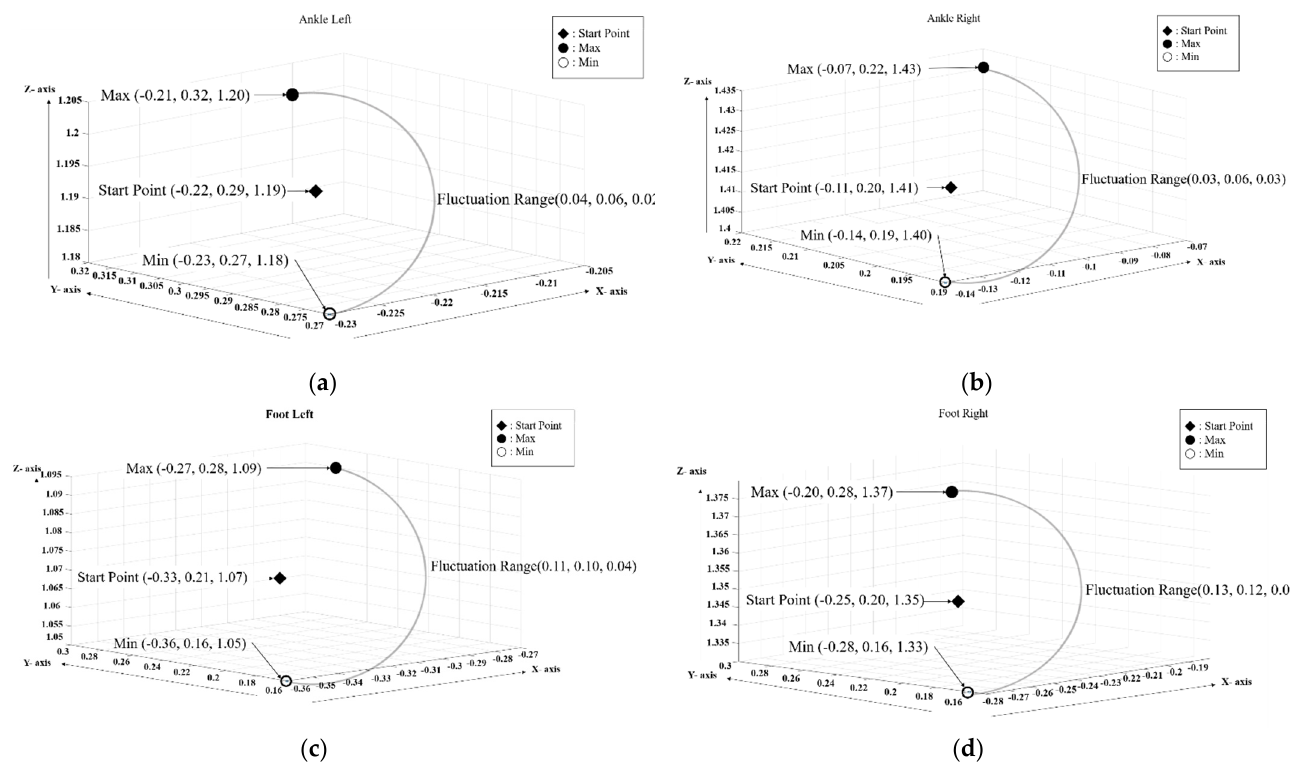
Figure 6. Measurement of Joint Vertex Movement (( a ) = Ankle Left, ( b ) = Ankle Right, ( c ) = Foot Left, ( d ) = Foot Right)